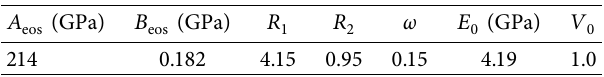
Figure 4: Meshing of rock mass model. Table 4: Parameters used in the JWL state equation for the explosive.